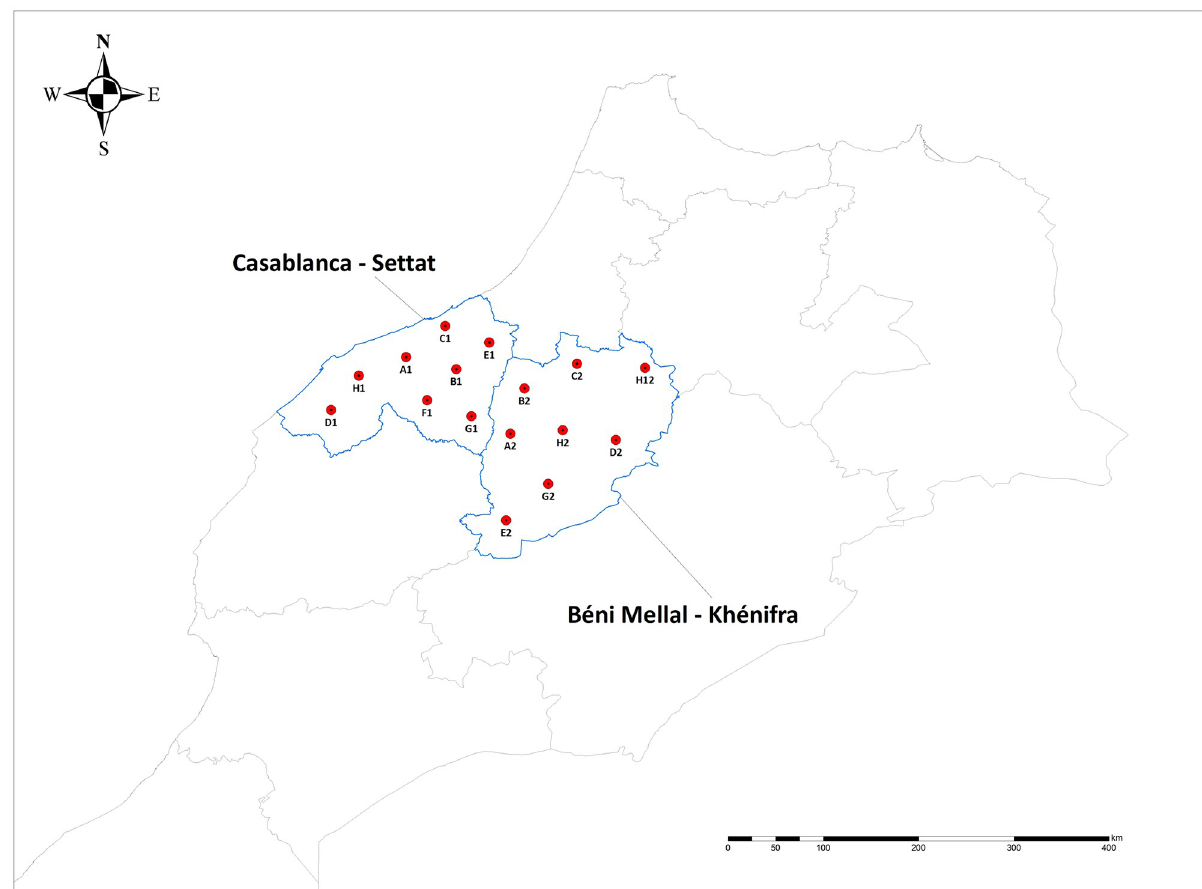
Fig 1. Geographical location of collection sites of A . corni colonies analyzed in this study (for details, see S1 Table in the supporting information).